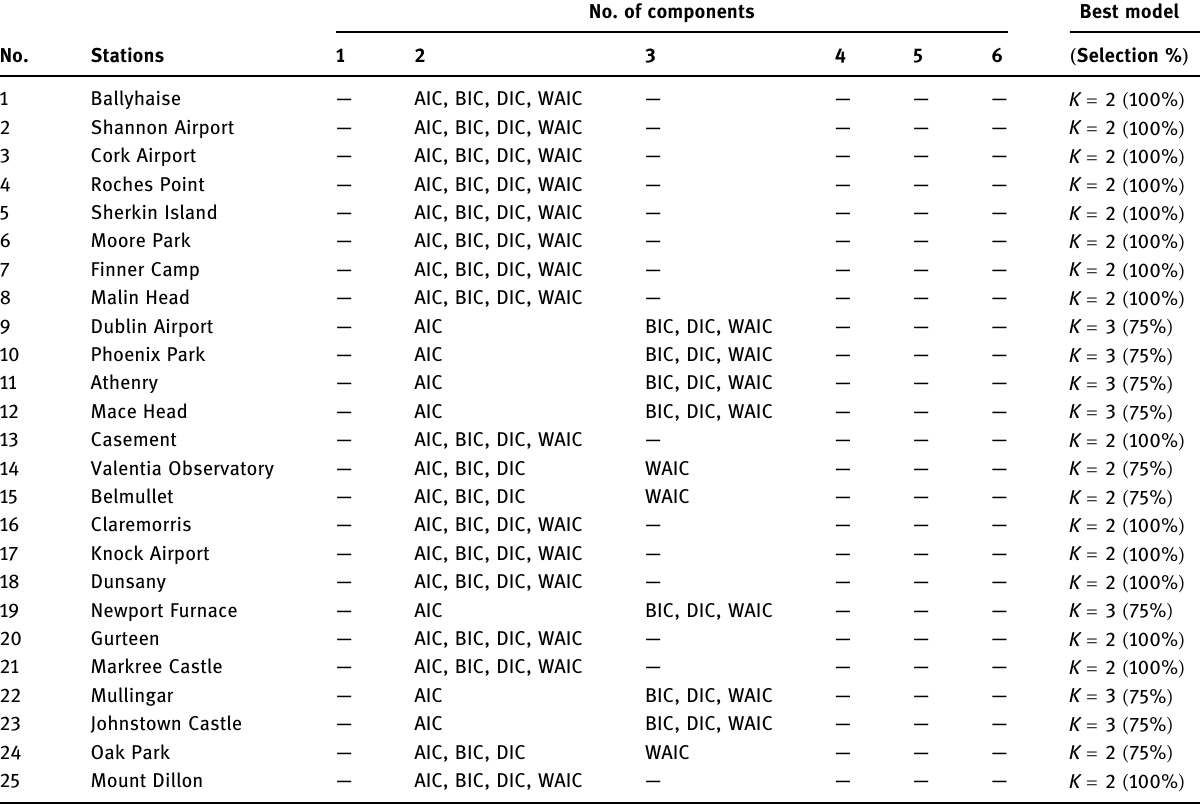
Table 2: Results of the best model selected by all or most selection criteria for every